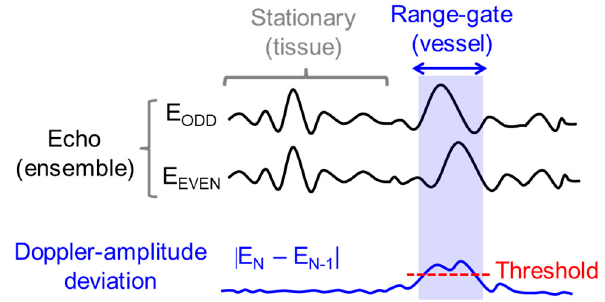
Figure 5. Concept of tracking a vessel region on a scanline.